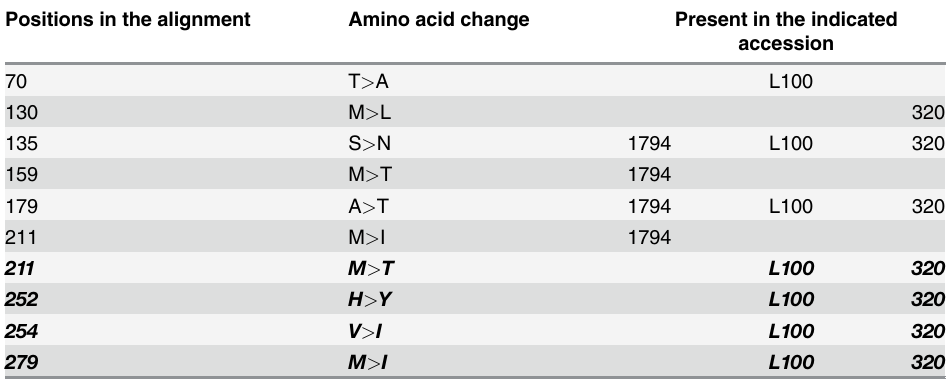
Differences occurring in two accessions, VIR320 and L100 with incompatible cytoplasms are boldfaced and